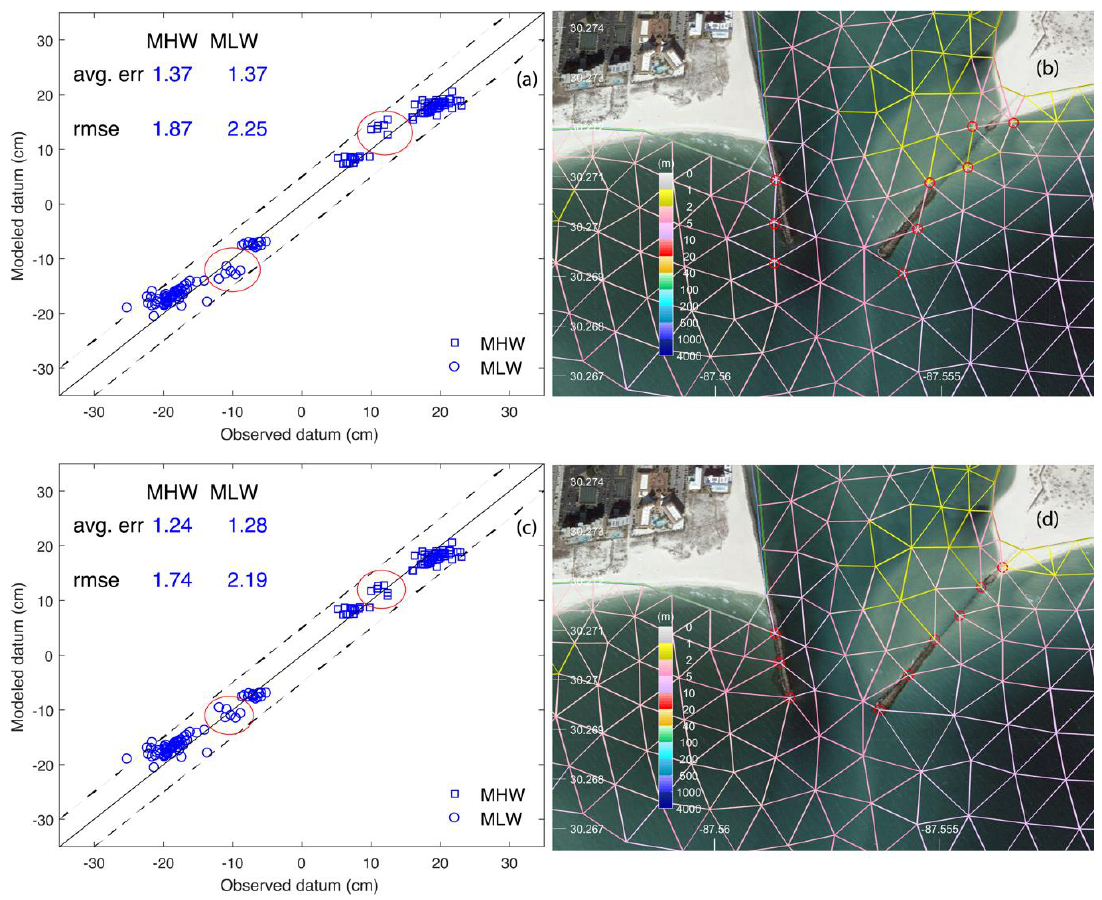
Figure 11. ( a , c ) Model data comparison at 74 stations in VDatum region ( b ) without and ( d ) with breakwaters at the entrance, respectively. Tide stations inside the Perdido Bay were within the red circle. Tests were conducted using the 2008 model grid. The dashed lines indicate the 5-cm error band.